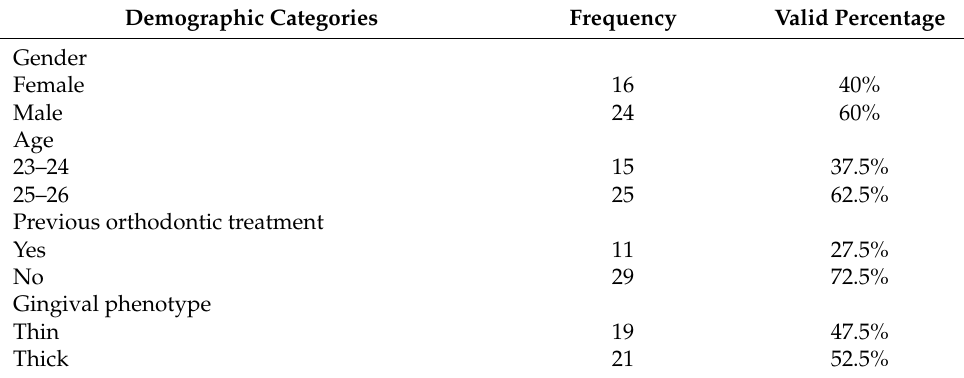
Table 1. Data demographic distribution.